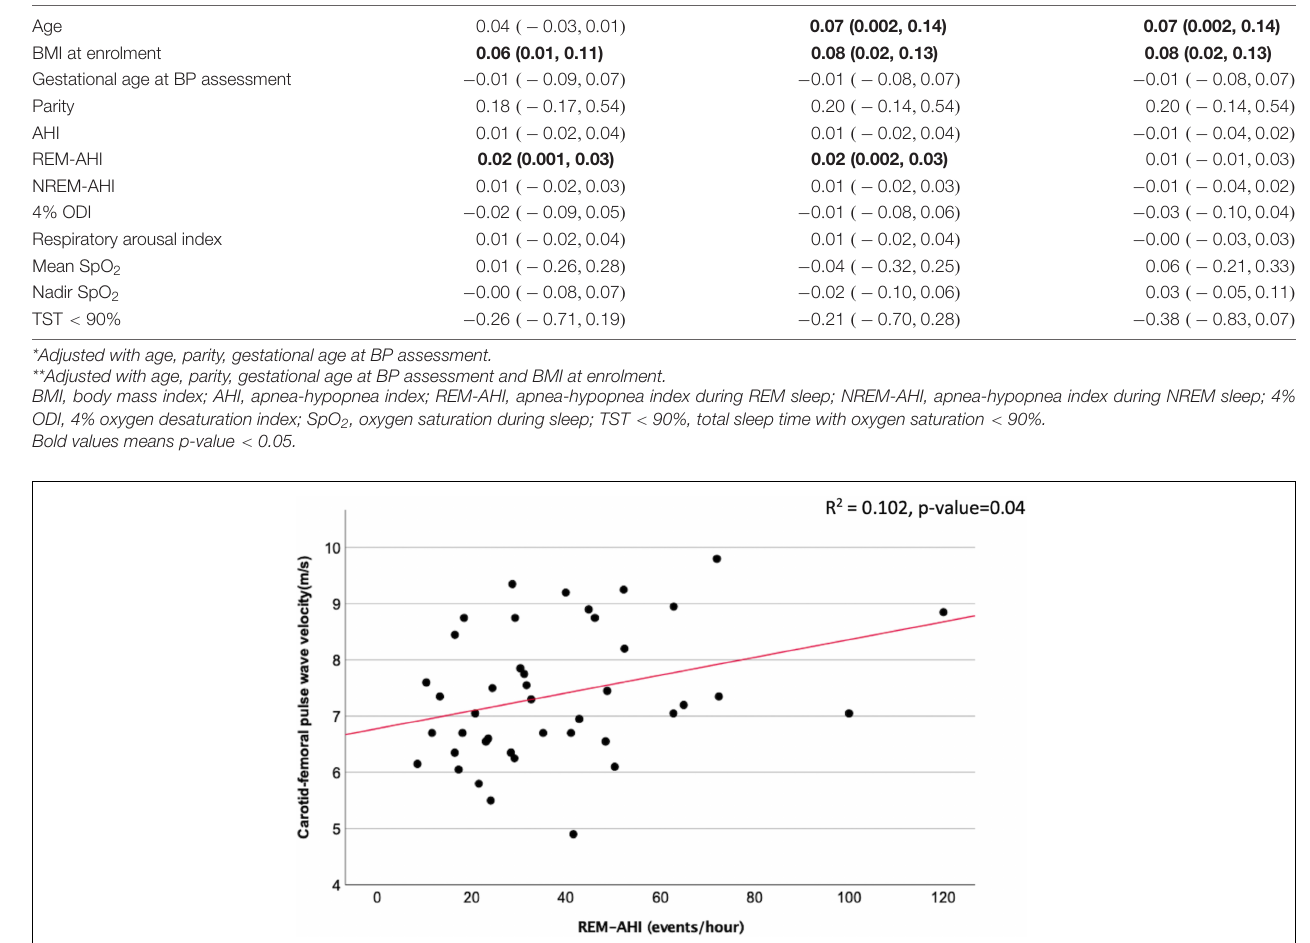
Frontiers in Physiology |